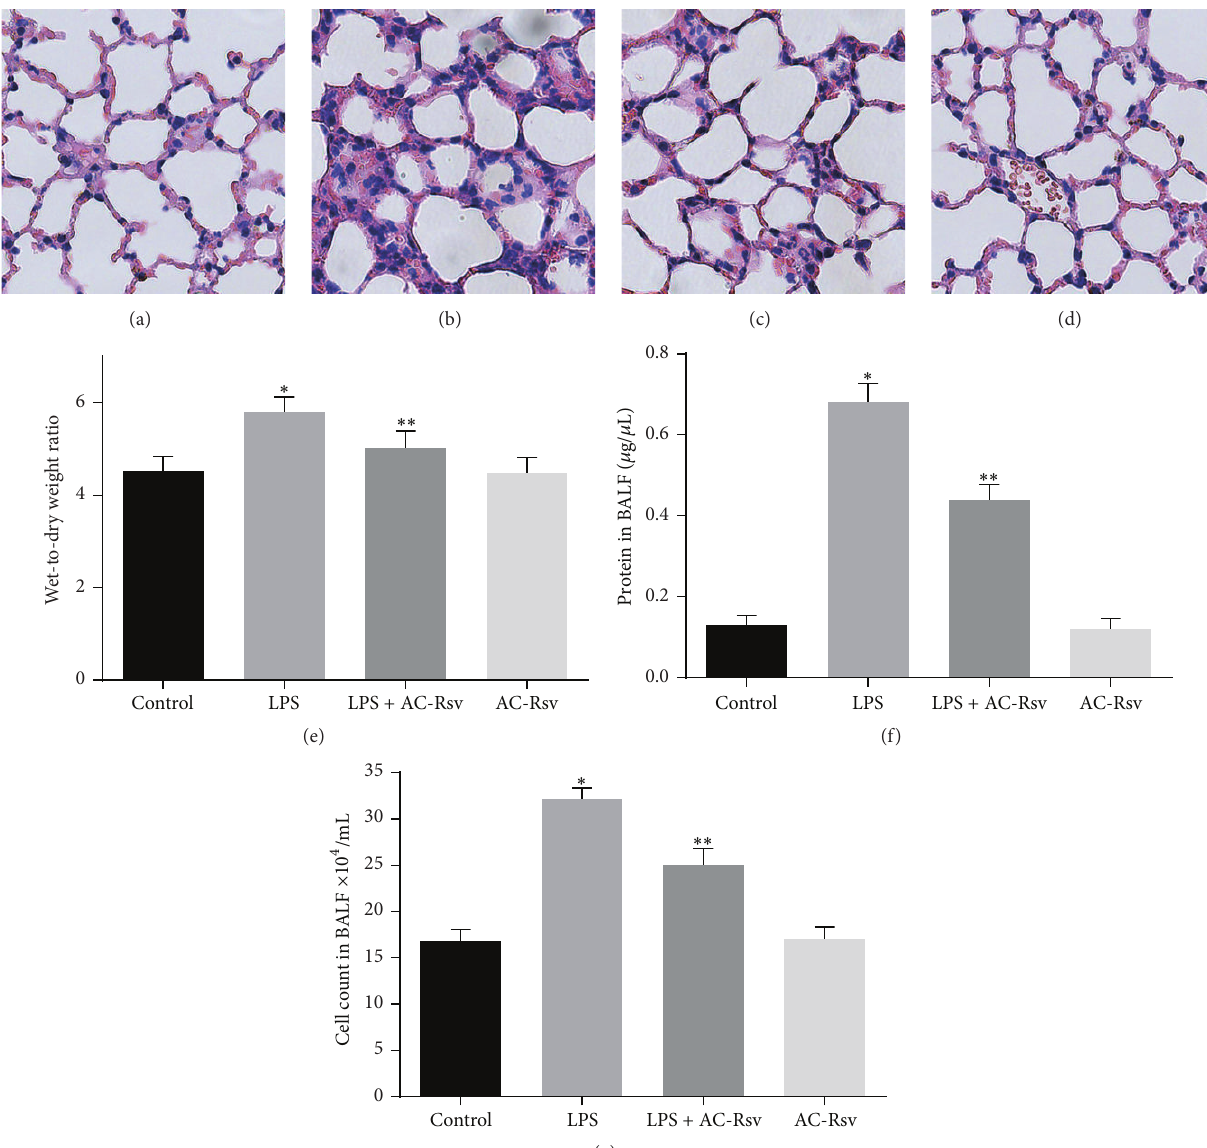
Figure 3: Protecting effects of AC-Rsv on the LPS exposure induced lung injuries. (a–d) Morphological changes were evaluated 12h after LPS exposure by H&E staining. LPS stimulation group (b) showed increasing lung edema, alveolar hemorrhage, neutrophil infiltration, and destroyed epithelial/endothelial cell structures compared with those of control (a), while significant improvement was observed in samples from the LPS + AC-Rsv group (c). AC-Rsv treatment alone barely affected the structure of lungs (d). (e) Wet-to-dry ratios of lung samples; data are expressed as mean ± S.D. 𝑛 = 8 . LPS injection significantly increased the W/D ratios of lung samples compared with that of control, ∗ 𝑃 < 0.05 versus control, while pretreatment of AC-Rsv dramatically decreased the W/D ratios of lung samples stimulated by LPS, ∗∗ 𝑃 < 0.05 versus ∗ 𝑃 . ((f) and (g)) Protein concentration (a) and cell count (b) in BALF. Data are expressed as mean ± S.D. 𝑛 = 8 . LPS exposure significantly increased cell and protein content in BALF compared with those of control, ∗ 𝑃 < 0.05 versus control; and pretreatment of AC-Rsv decreased the cell and protein content in BALF from lung stimulated by LPS, ∗∗ 𝑃 < 0.05 versus ∗ 𝑃